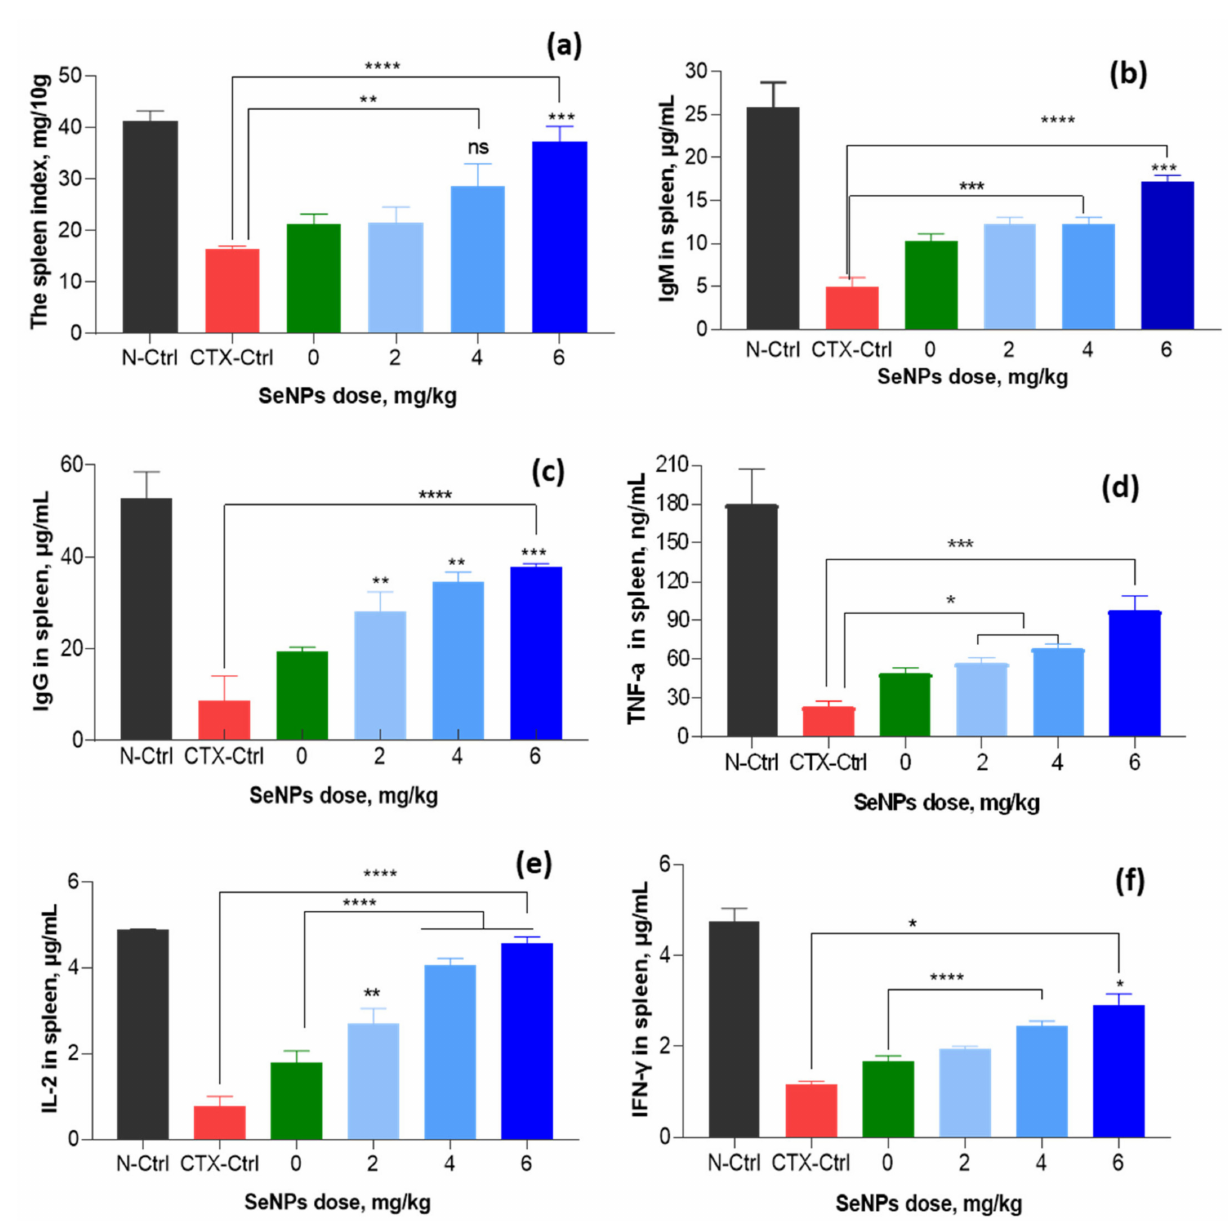
Figure 14. Effect of SeNPs/ β -glucan concentration on immunity factors in spleen of immunosuppressed mice. ( a – f ) are spleen, IgM, IgG, TFN- α , IL-2 and IFN- γ indexes, respectively; N-Ctrl: Normal control mice received only distilled water; CTX-Ctrl: CTX-induced immunosuppressive mice received only distilled water; in supplemented groups, mice were orally supplied with 0 (only β -glucan without SeNPs), 2, 4 and 6 mg SeNPs kg − 1 . Significant differences were compared with the CTX-Ctrl. ns, not significantly different at p > 0.05; *, significant different at p < 0.05; **, significant different at p = 0.01, *** significant different at p < 0.01; ****, significant different at p < 0.001. Data were statistically analyzed using the ANOVA test and expressed as means ± SD, n =